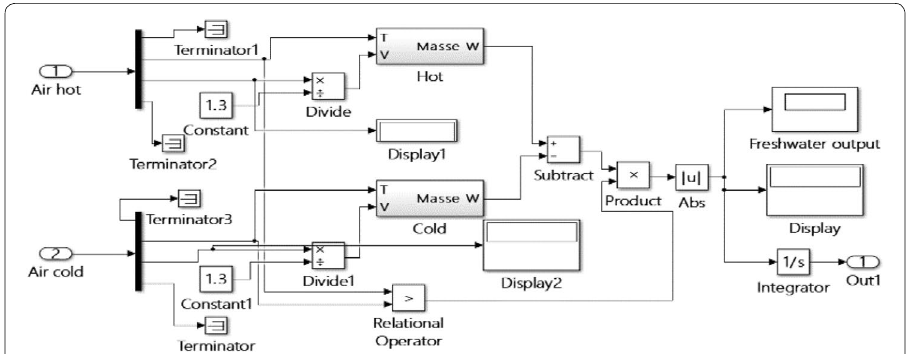
Fig. 4 Calculation of the freshwater production depending on temperatures and volume flow rates